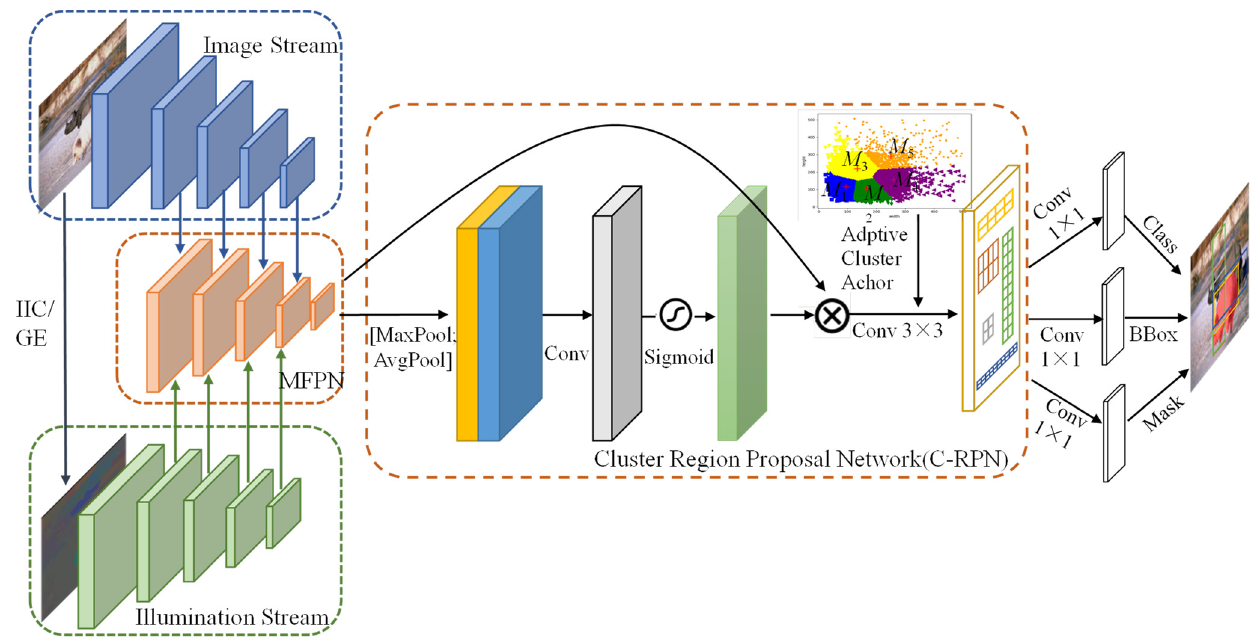
Figure 1. Overview of the proposed framework, where the image stream and the illumination stream extract semantic features and tampered features, respectively. The two stages are fused by MFPN and C-RPN is to locate tampered regions. ⊗ denotes matrix multiplication.